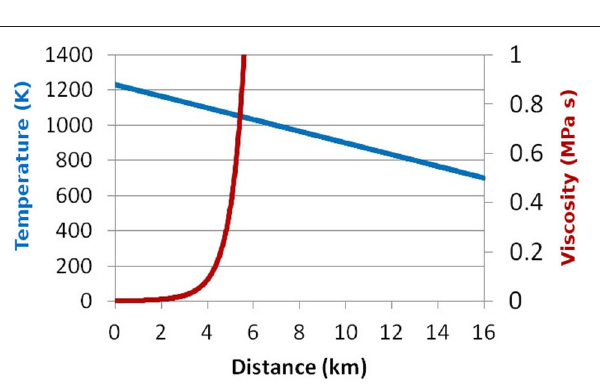
FIGURE 12 | Viscosity of a latitic magma (red line, right axis) as a function of radial distance of the sill front from the point of magma injection, assuming a linear variation of magma temperature (blue line, left axis). The viscosity is calculated following Misiti et al.